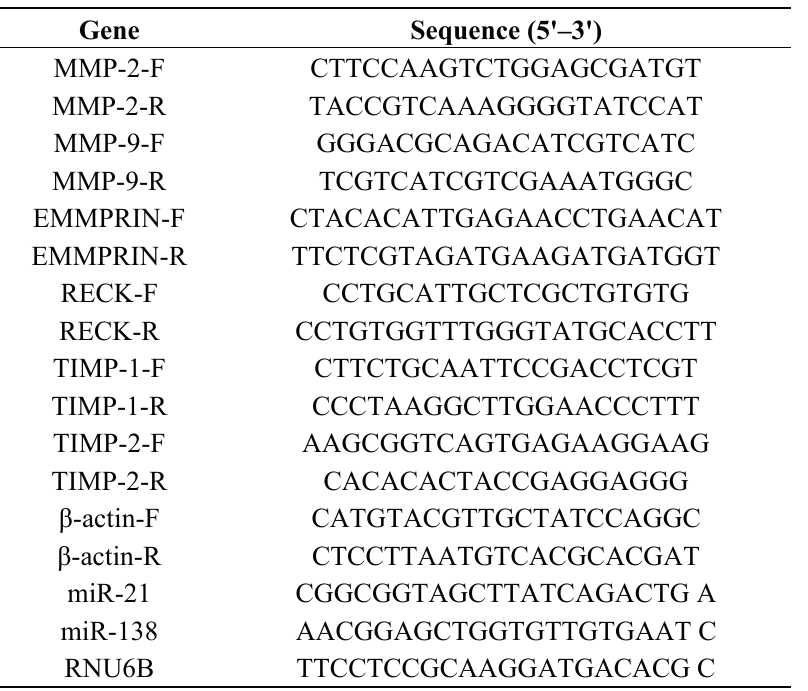
Table 1. Primer pairs used in Quantitative Real-Time PCR.